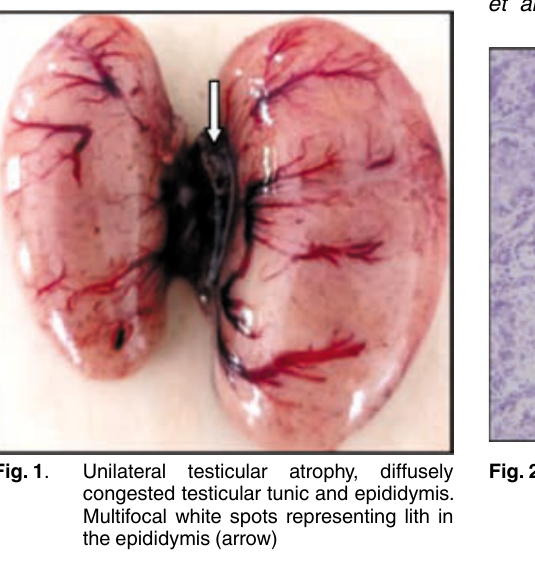
Fig. 1 . Unilateral testicular atrophy, diffusely congested testicular tunic and epididymis. Multifocal white spots representing lith in the epididymis